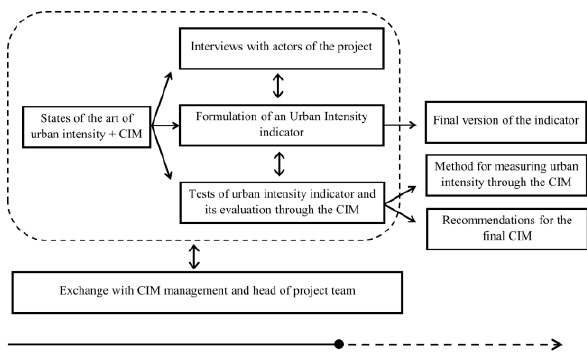
Figure 1 . Our methodology and where we are in the process (●) We aim to propose a useful and usable intensity indicator, methods for measuring at least some of its aspects using the CIM and recommendations for the final version of the CIM. We now have a first version of the intensity indicator, we have tested the measurement of some criteria through the CIM and we are still conducting